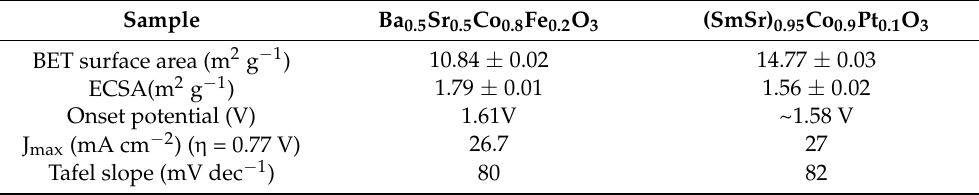
Figure 6. Nitrogen adsorption/desorption isotherm patterns of (SmSr) 0.95 Co 0.9 Pt 0.1 O 3 ( a ) and Ba 0.5 S r0.5 Co 0.8 Fe 0.2 O 3 (BSCF-5582) ( b ). Figure 5b shows Tafel slope plots for (SmSr) 0.95 Co 0.9 Pt 0.1 O 3 and BSCF, measured in 0.1 M KOH solution at 1 mV/s. Tafel slope of (SmSr) 0.95 Co 0.9 Pt 0.1 O 3 was 82 mV dec −1 , which